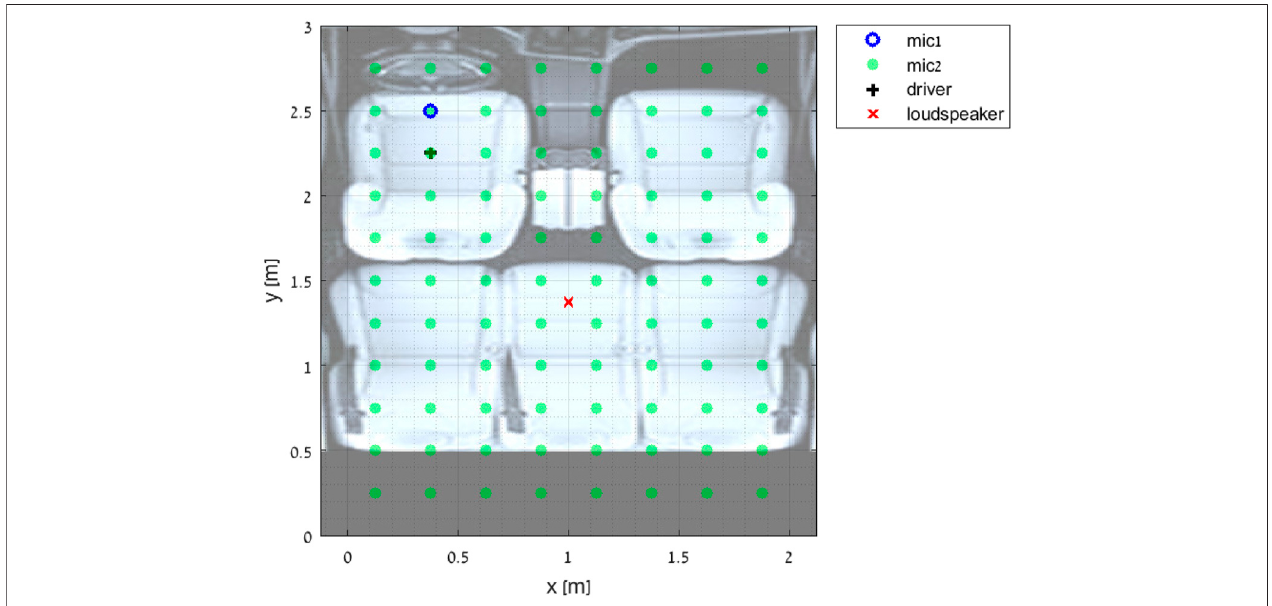
FIGURE 5 | An illustration of the car-cabin room con fi guration, in the XY